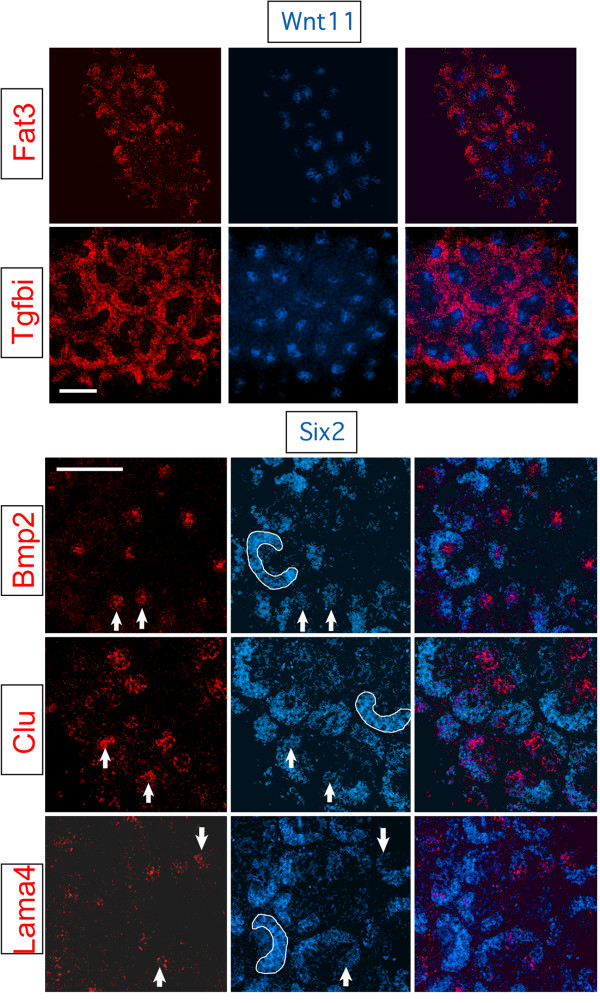
Dual-label fluorescent whole mount in situ hybridization studies showed the expression patterns of a set of genes which have a changing level of expression after birth. Tgfbi and Fat3 were expressed in the nephron progenitor mesenchyme (red signal) surrounding ureteric bud branch tips (blue - Wnt11 riboprobe) at P2. Bmp2, Clu, and Lama4 (red) were expressed in the nephron anlage, and were also co-expressed (arrows) with Six2 (blue) in capping mesenchyme. Selected regions of capping mesenchyme are outlined with a white line. Bars = 100 microns.